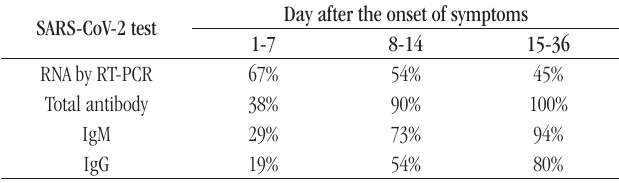
TABLE – Sensitivity tests in relation to the days after the onset of symptoms.